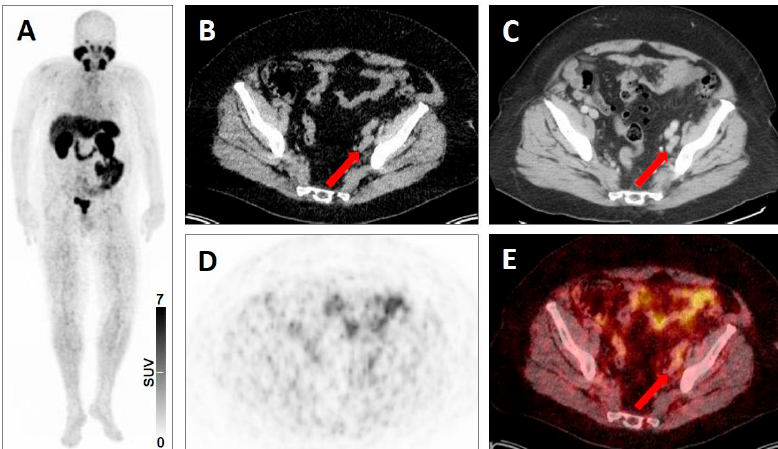
Figure 7. Equivocal uptake in soft-tissue lesion typical of prostate cancer lesion on PSMA-targeted positron emission tomography (PET) / computed tomography (CT). 68 Ga-PSMA-11 PET / CT for restaging in a 73-year-old man with a history of a prostate cancer. Whole-body maximum intensity projection image showing absence of clearly pathologic radiotracer uptake ( A ). Axial low-dose CT ( B ), contrast-enhanced CT ( C ), PET ( D ), and fused PET / CT ( E ) showing an iliac lymph node typical of a prostate cancer lesion on anatomic imaging, but with equivocal uptake (red arrows), consistent with a PSMA-RADS-3A